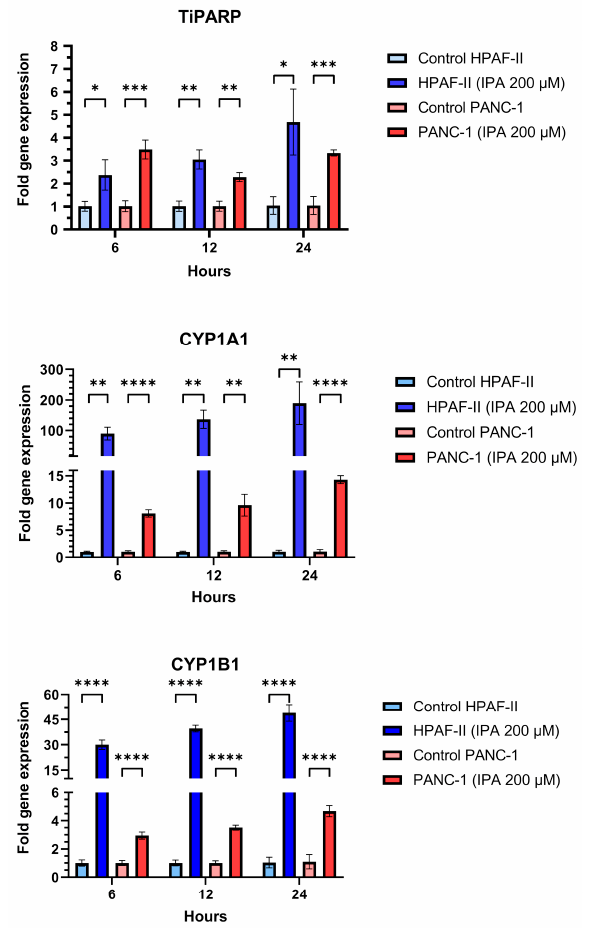
Figure 4. Effect of IPA treatment on mRNA expression of TiPARP, CYP1A1, and CYP1B1. PANC-1 and HPAF-II were treated with IPA for 6, 12, and 24 h and the mRNA expression of TiPARP, CYP1A1, and CYP1B1 was determined from the collected RNA of each sample using qPCR. The graphs represent the relative expression of each gene using the formula 2 − ∆∆ Ct normalized to the mean ∆ Ct of control cells. Data are represented as mean ± SD ( n = 3). Statistical comparison between IPA-treated and untreated (control) cell lines were performed using an unpaired Student’s t -test and the significant differences are indicated by asterisks (**** p ≤ 0.0001, *** p ≤ 0.001, ** p ≤ 0.01, * p ≤